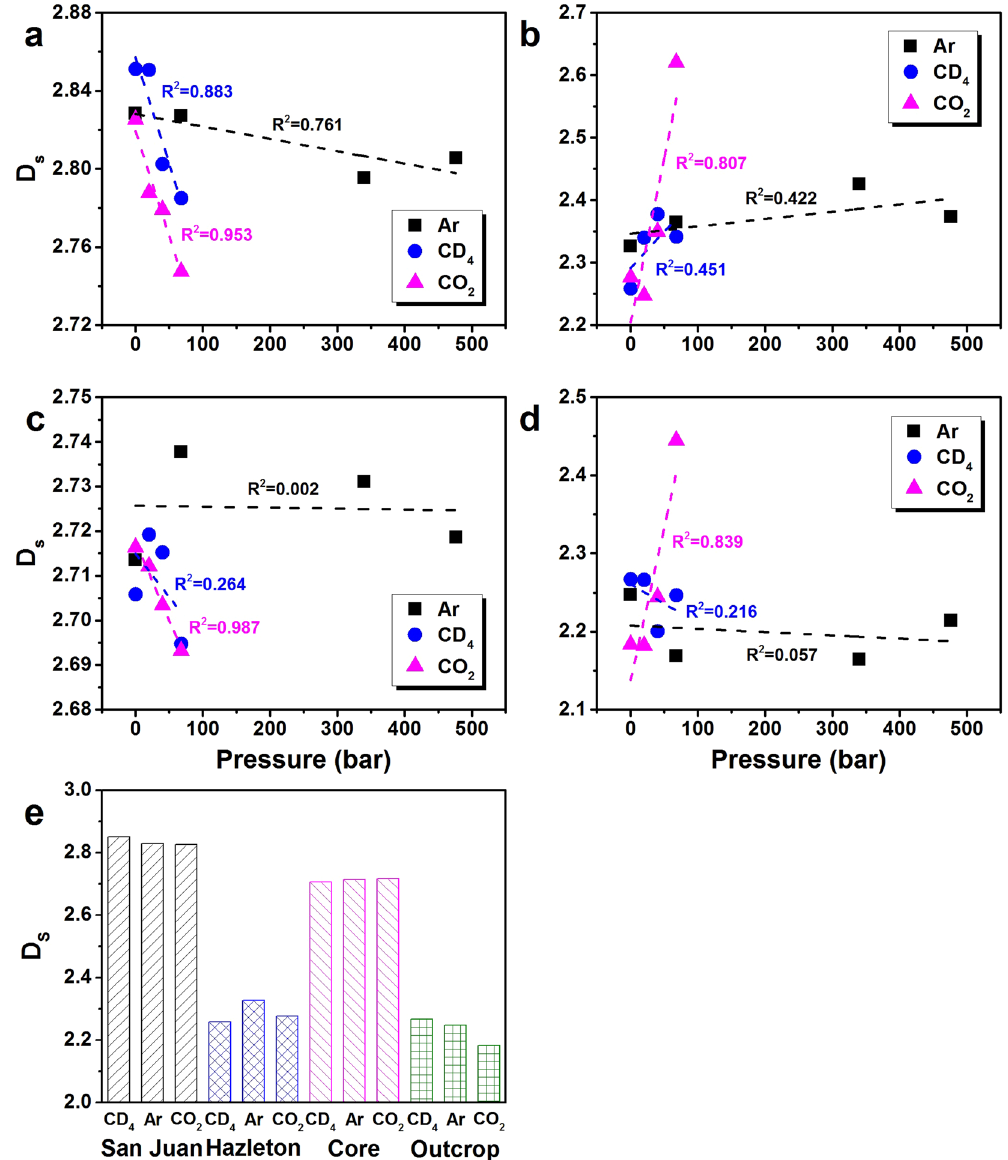
Figure 4. Evolution of fractal dimension based on argon, methane and CO 2 penetrations. ( a ) San Juan coal; ( b ) Hazleton coal; ( c ) Marcellus drilled core shale; ( d ) Marcellus outcrop shale; ( e ) vacuum conditions for four